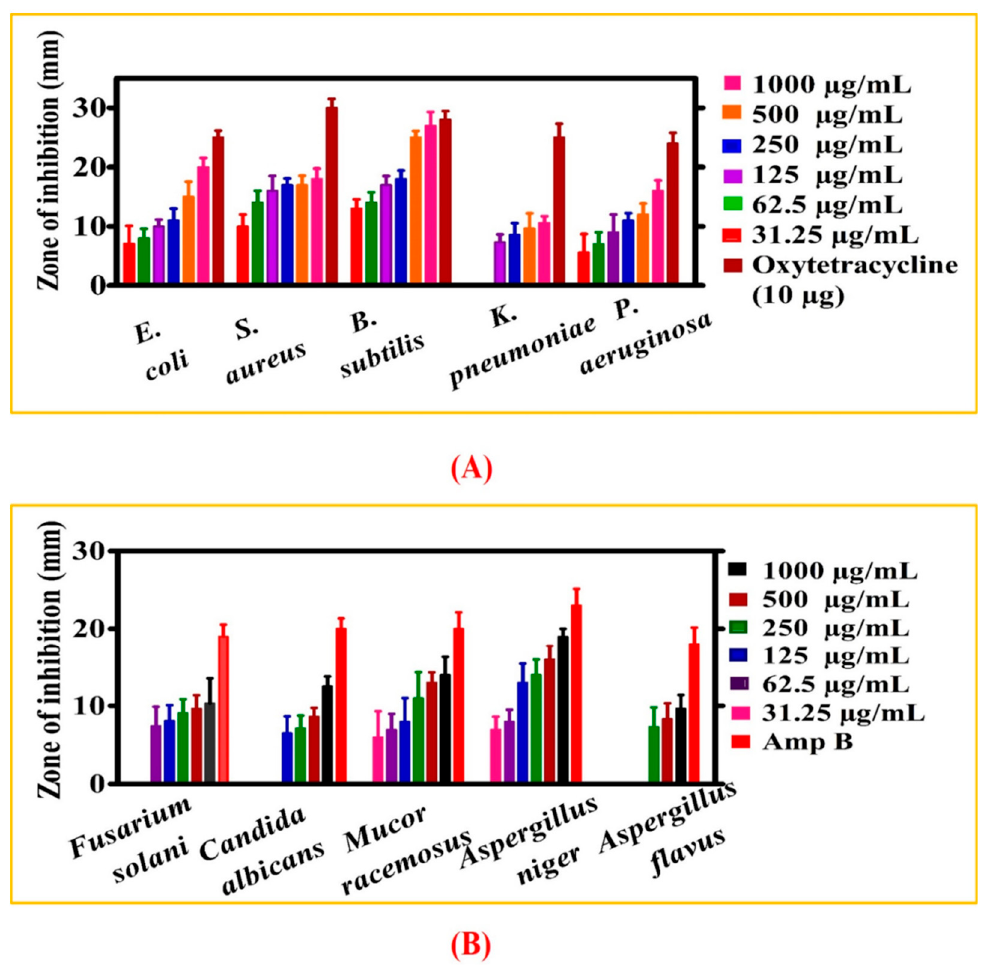
Figure 7. Antibacterial and antifungal assays. The data in all figures represents the mean of three replicates ( A ) Antibacterial potential of biogenic ZnONPs ( B ) Antifungal potential of biogenic ZnONPs.